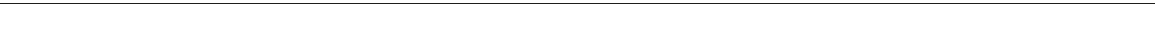
Fig. 2 Tn5-based ChIP assays produce a high degree of sequence bias in reads. a Heatmaps comparing assay variants at the top 200 S. cerevisiae Ume6 motifs in a 200 bp (top) or 2 kb (bottom) window. Tag 5 ′ ends located on the motif strand are indicated in blue, and those located on the opposite strand are in red. Rows are linked and sorted (in all fi gures) based on motif-associated tag intensity derived from ChIP-exo 5.0 (our preferred method). b Frequency distribution of library insert sizes determined by paired-end sequencing for assay version shown in panel ( a ). Dotted lines indicates the modal insert size within each dataset. The numbers in parentheses represent the insert size mode plus/minus one standard deviation. c Proposed model of multi- tagmented DNA in ChIPmentation. Following tagmentation, Tn5 (blue spheres) does not dissociate, allowing the excess cut DNA (brown and gray lines) to remain noncovalently bound to the ChIP DNA (black lines with green sphere) through the end of library prep. This results in a mixture of forward and reverse strand tags at the original tagmentation sites that appear purple when viewed in a heatmap (purple asterisks). d Nucleotide frequency at the 5 ′ end of Read_2 sequencing tags (and thus not exonuclease digested) generated through tagmentation. Black dotted lines indicate the background nucleotide frequency of A/T (31% each) and G/C (19% each) content in S. cerevisiae . The observed sequence bias is displayed above the graph